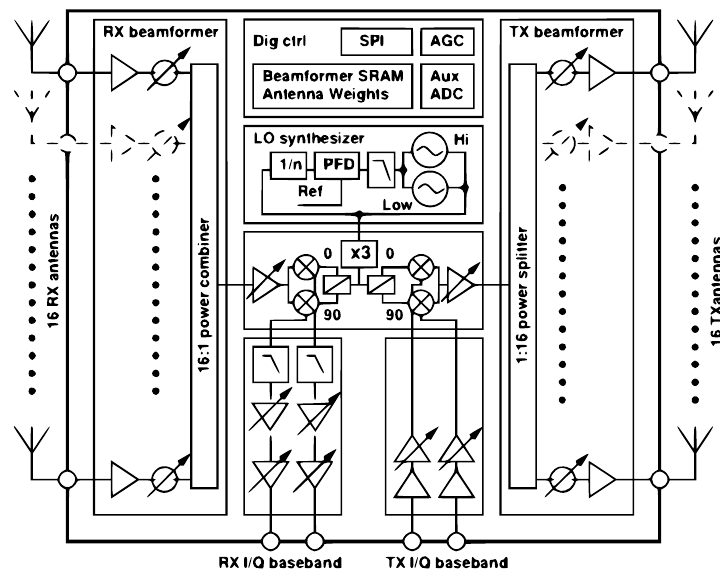
Fig. 1 Block diagram of the 16 TX/16 RX transceiver chip showing the beamforming blocks, up-/down-converter, LO generation, TX/RX baseband, and digital control block